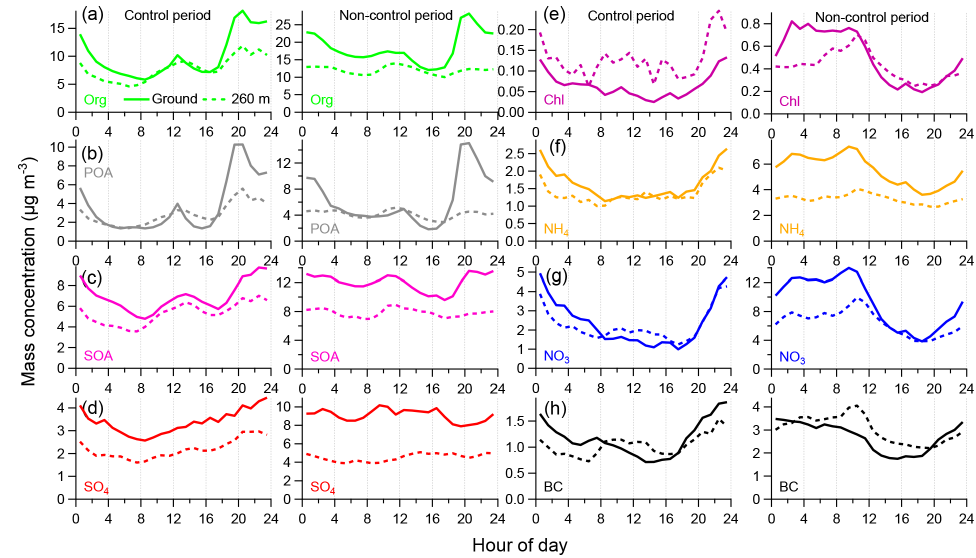
Figure 8. Diurnal variations of PM 1 species at ground level (solid lines) and 260m (dash lines) during the control and non-control